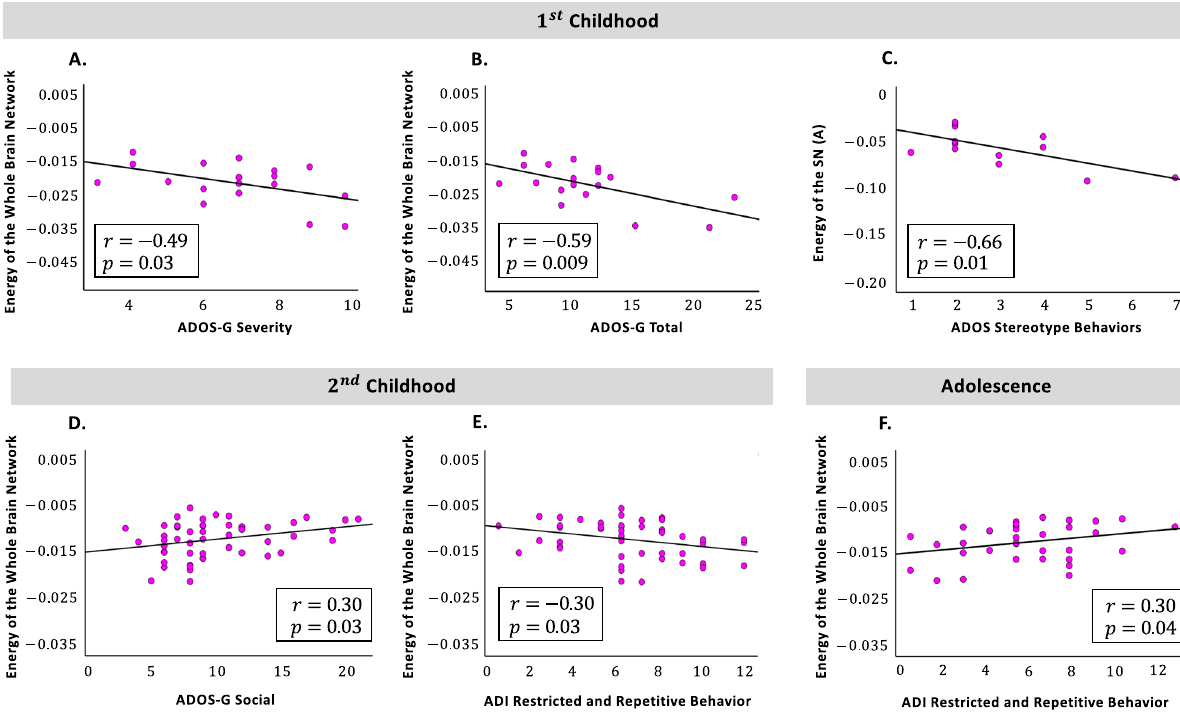
Figure 4. Pearson’s correlation coefficients between network measures and behavioral scores. ( A – C ) During 1st childhood, ADOS-G severity and total scores show negative associations with the whole brain energy. As like, energy of the SN ( A ) is negatively associated with ADOS stereotype behaviors. ( D , E ). During 2nd childhood, energy of the whole brain network positively correlates with ADOS-G social scores and negatively with ADI restricted behaviors. ( F ) For adolescents energy of the whole brain network is positively correlated with ADI restricted behaviors. SN, the salience/ventral attention network; ADI, the autism diagnostic interview; ADOS, the autism diagnostic observation schedule; ADOS-G, the autism diagnostic observation